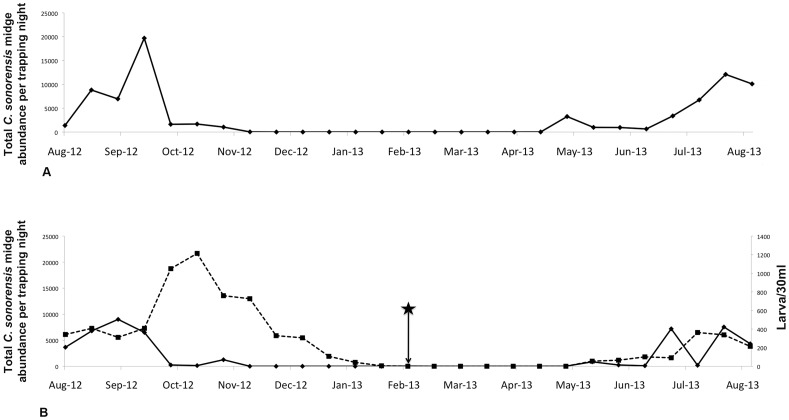
Seasonal abundance of C.sonorensis collected on each farm.A) Seasonal abundance of adult (adults per trap per day) Culicoides sonorensis collected on dairy Farm A; B) Seasonal abundance of immature (larvae/30 ml sample) (dashed line) and adult (adults per trap per day) (solid line) Culicoides sonorensis collected on dairy Farm B. The star denotes capture of 32 parous females during the month of February on the site with a lagoon present.